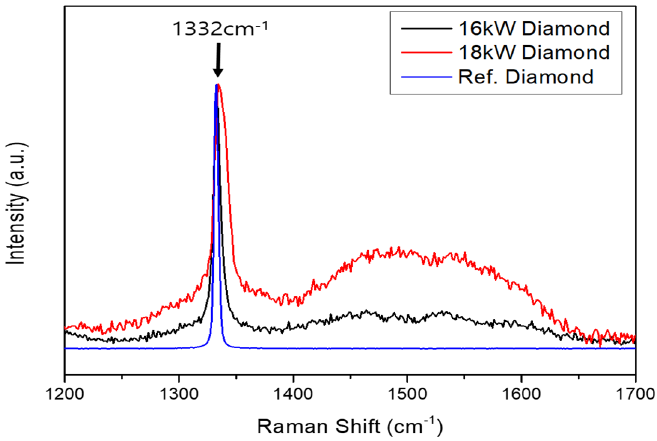
Figure 7. Raman spectroscopy of 16 kW/18 kW diamond films and standard diamond specimens.